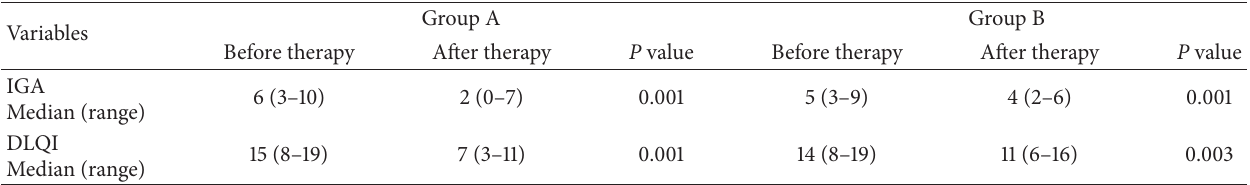
Figure 3: Significant improvement of sclerotic preputial ring and partial repigmentation of the ventral surface of the glans. Table 1: Values median (range) of IGA and DLQI scores before and after therapy in group A and group B; comparisons are evaluated using paired Wilcoxon signed-rank for paired